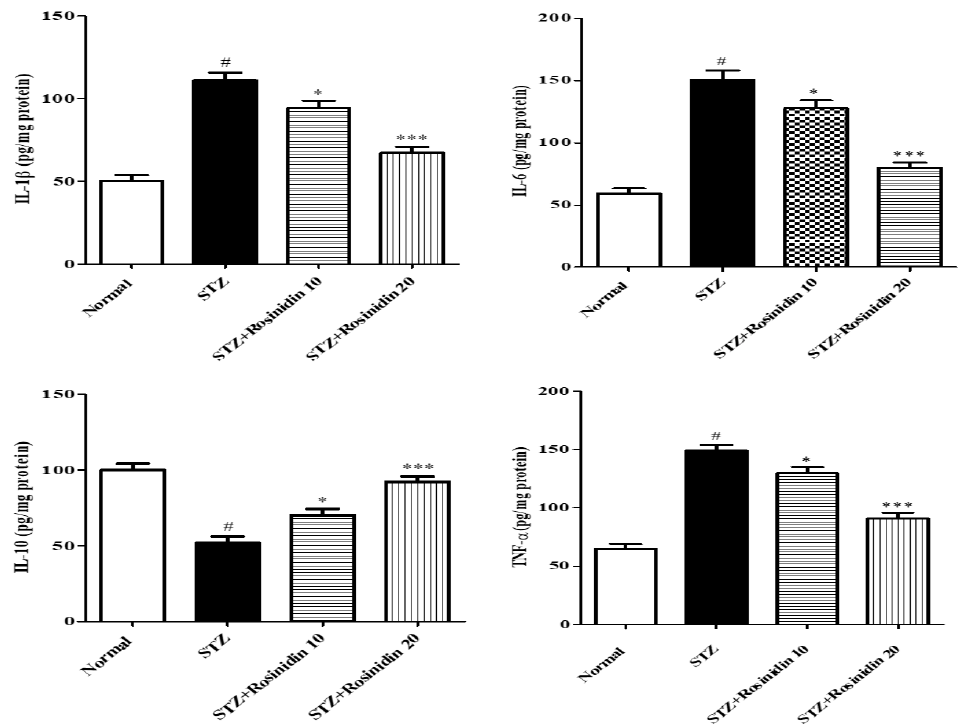
Figure 7. The effect of rosinidin on the neuroinflammatory cytokine levels. All the values are presented as the mean ± SEM. Correlation among the groups was done using Tukey’s test by one-way ANOVA. p -value < 0.001, 0.05 were expressed as ***, * respectively as compared with the streptozotocin (STZ) group. # significant as compared with the controls ( p < 0.001).